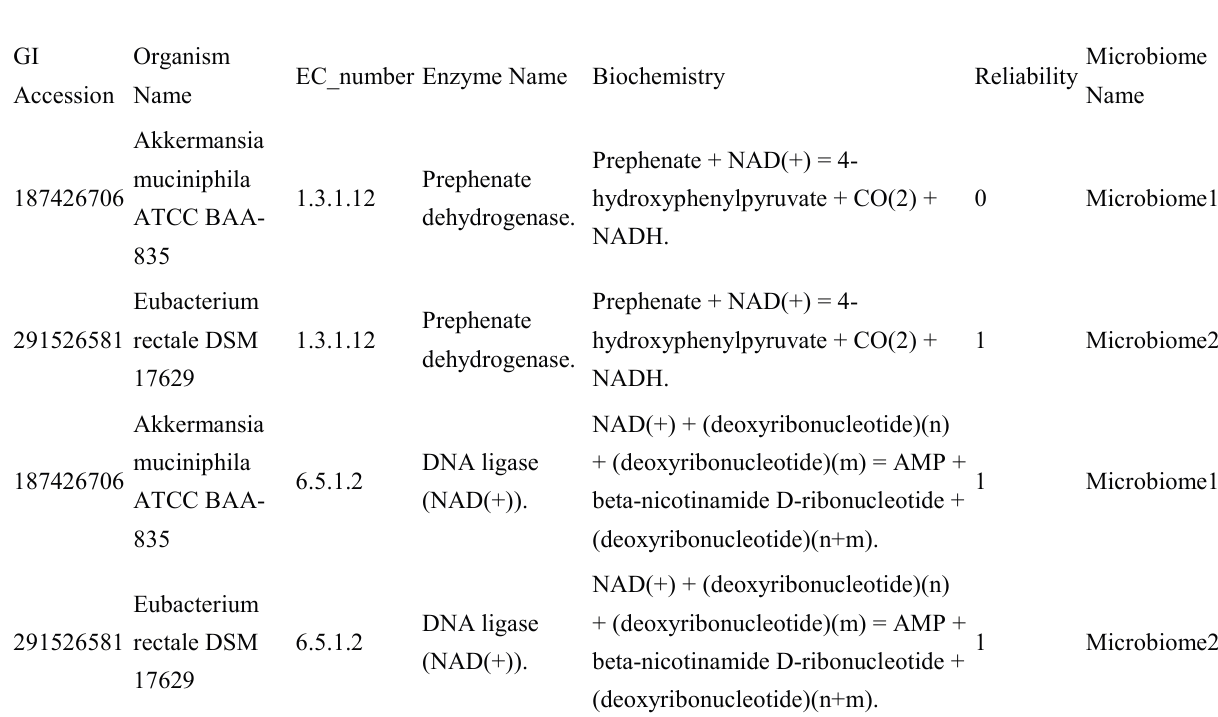
Figure 2. Example extract from the original software results